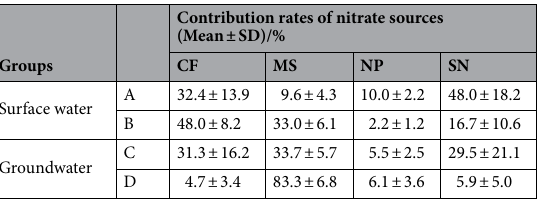
significant spatiotemporal variation, which caused by the combination of precipitation, hydrogeology, land-use, and hydrological processes. Considering the spatial heterogeneity of nitrate sources, the squared Euclidean dis- 29 surface water samples were divided into two groups (A and B) by hierarchical cluster analysis (Figure S3). Group A (Htt1-Htt, Hzx4-Hzx11) corresponds to surface water from the mid-upper reaches of the Zhangxi and Tangtian Rivers, and group B (Htt5, Htt6, Hzx1-Hzx3, S1-S6, H11, H12, H21, H31, H32 and H41) corresponds to lake water, surface water in the lower reaches of the Zhangxi and Tangtian Rivers, and surface water in Dadukou, which are most heavily polluted by agricultural nonpoint-source pollution and living point-source pollution. 33 groundwater samples into two groups (C and D) also divided through hierarchical cluster analysis (Figure